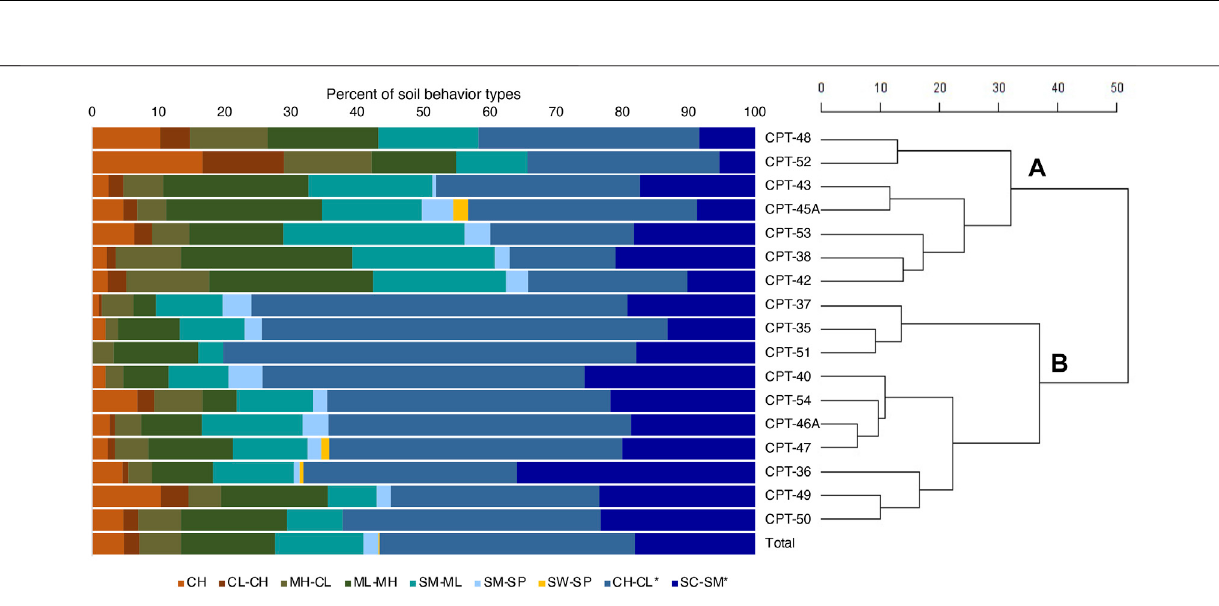
Frontiers in Environmental Science |